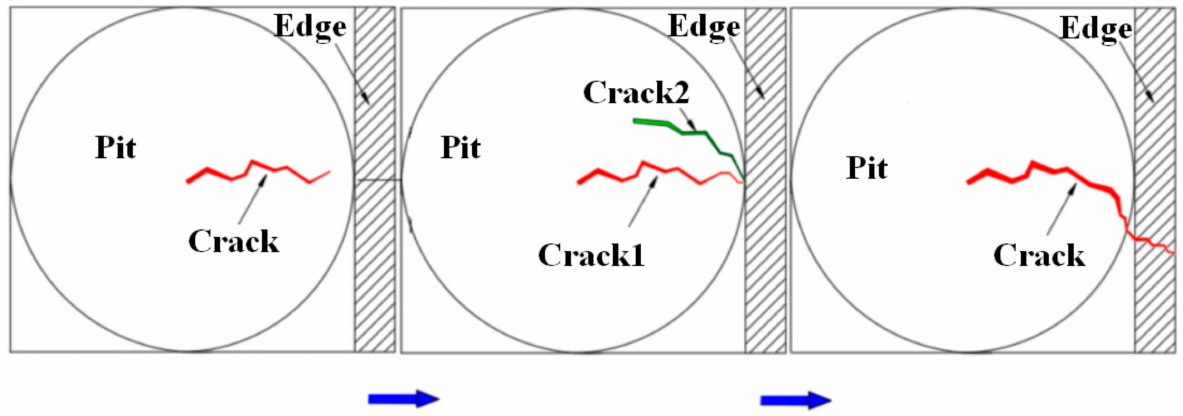
Figure 7. Schematic diagram of a single edge retarding crack propagation model of a quadrilateral pit